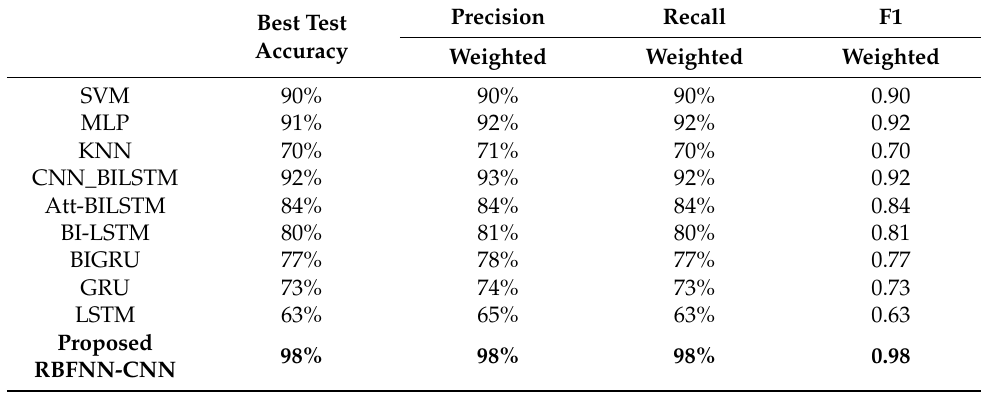
Table 3. Average speaker identification performance using SUSAS